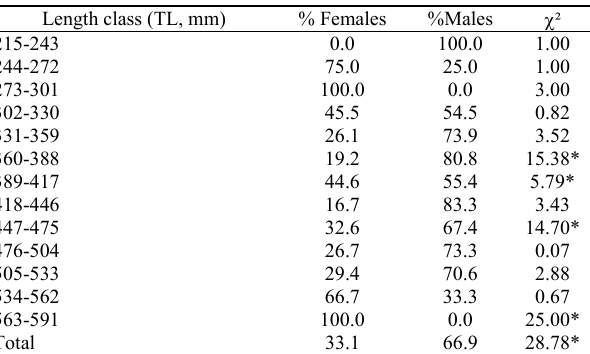
Table 3. Sex ratio by total length class for Plagioscion magdalenae in the bay of Marajo. *Significant at 5% level.